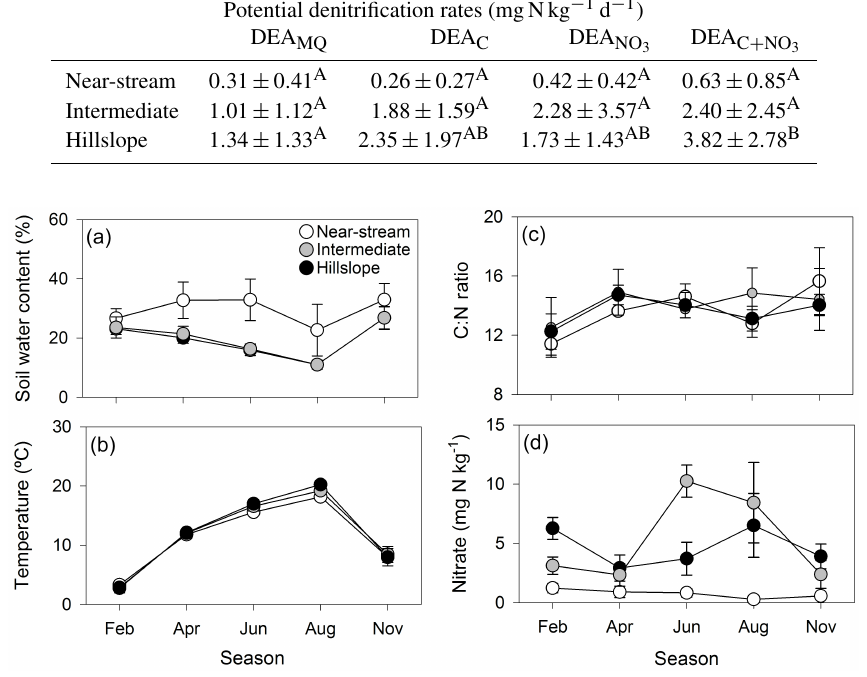
Figure 3. Temporal pattern of (a) soil water content, (b) soil temperature, (c) soil C:N molar ratio, and (d) soil nitrate concentration at 10cm depth. Data are shown for the near-stream (white), intermediate (grey), and hillslope (black) zones during the study period. Circles are mean values and error bars are standard